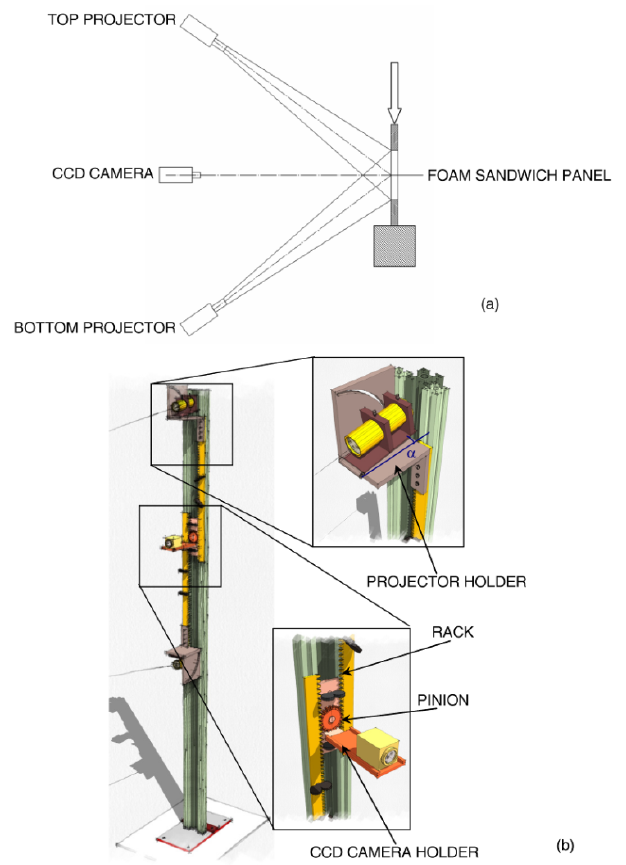
Figure 2. ( a ) Schematic of the two-projector moiré set-up utilized to measure out-of-plane deformation of foam-based sandwich panels; ( b ) the frame supporting the optical